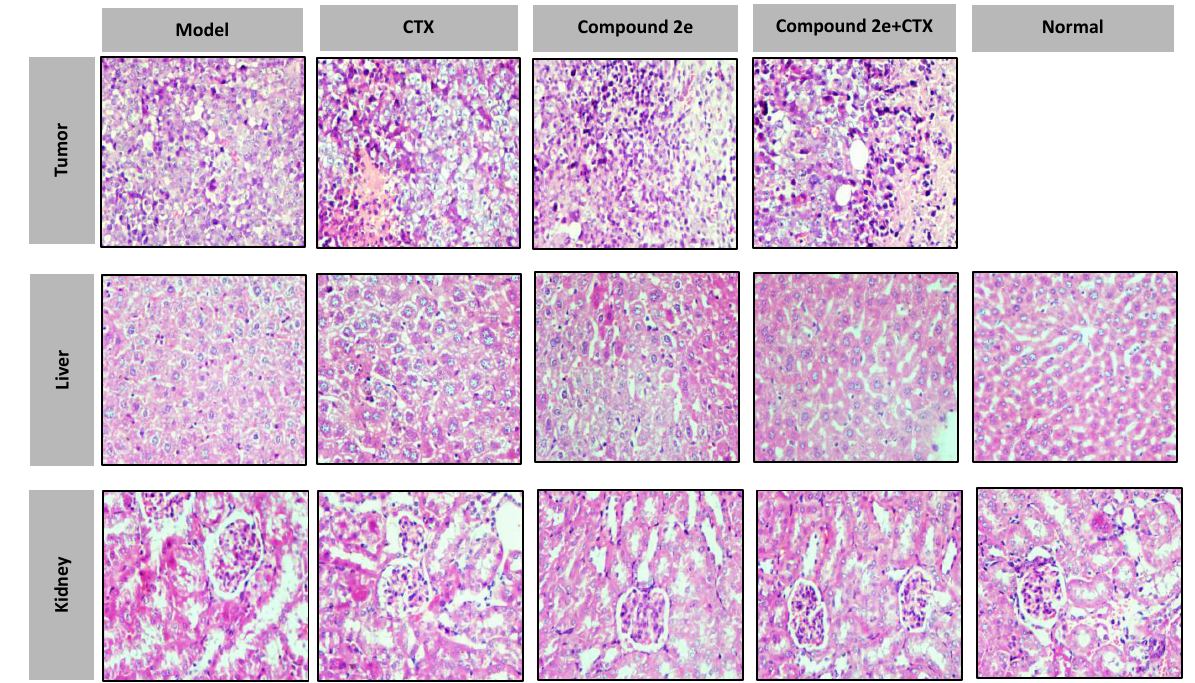
Figure 4. Histological examination of morphological changes in tumor, liver and kidney.